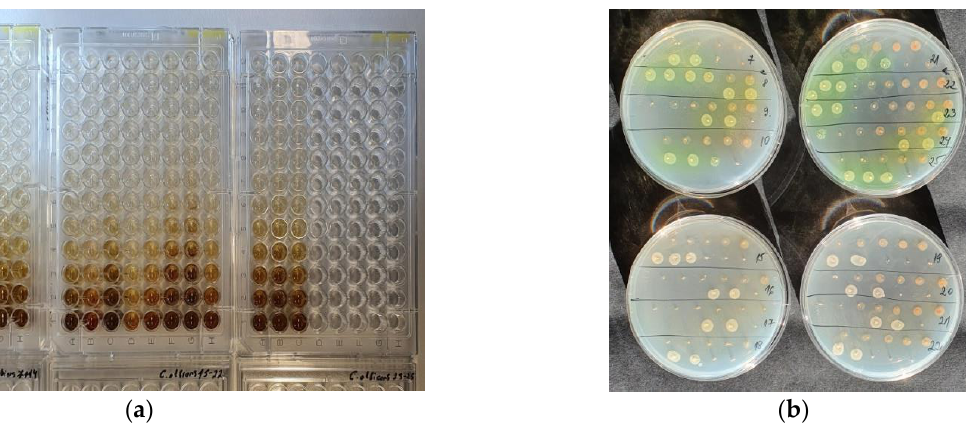
Figure 12. ( a ) Minimum inhibitory concentration (MIC) of ‘Maria Bruvele’ extract against C. albicans in 96-well plates by the two-fold serial broth microdilution method; ( b ) Minimum bactericidal concentration (MBC) of ‘Maria Bruvele’ extract against P. aeruginosa and minimum fungicidal concentration (MFC) against C. albicans .